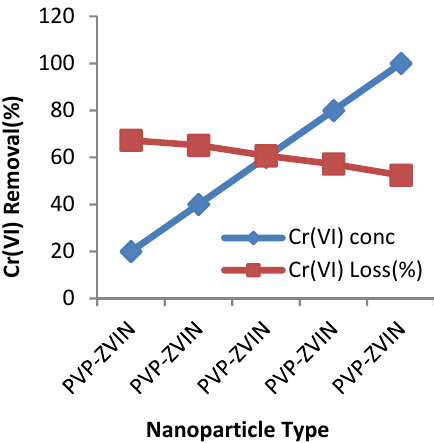
Fig.8.The removal efficiency of Cr(VI) using bare ZVINs as a function of Cr(VI) concentrations